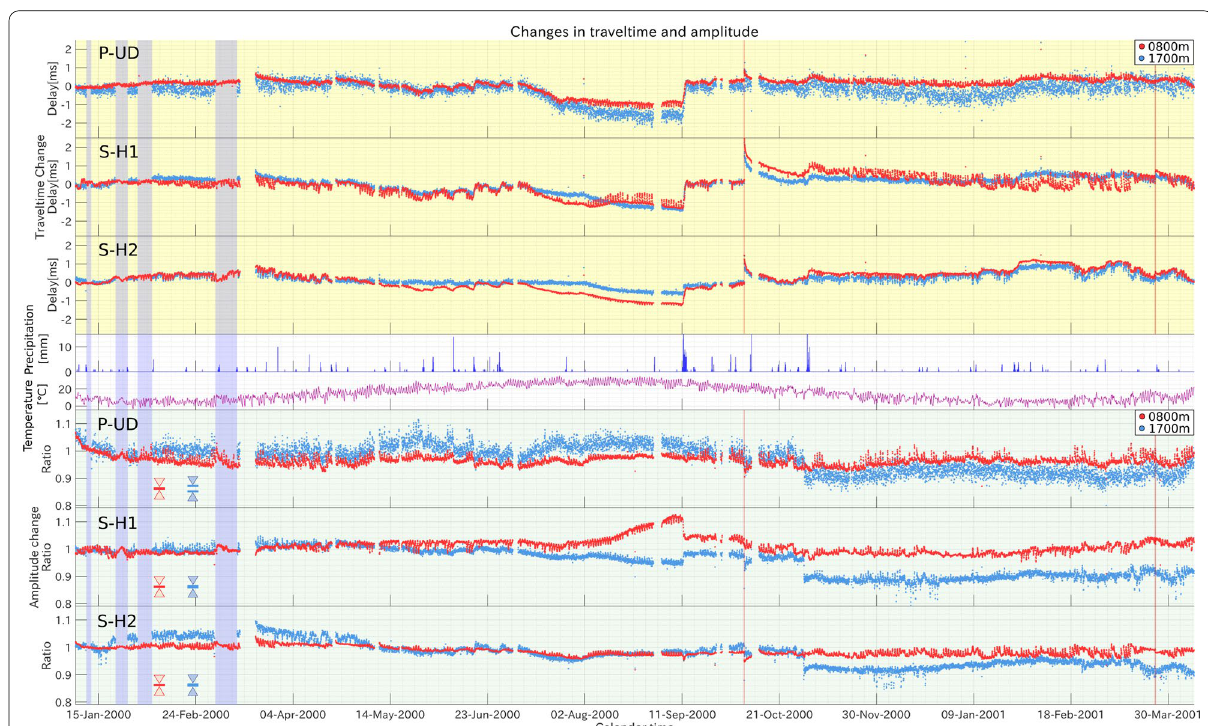
Fig. 5 Change in travel time and amplitude throughout the observation period. The changes in travel time (top three panels with yellow background) are calculated according to Ikuta et al. (2002) and changes in amplitude (bottom three panels with green background) are obtained by our method. The two panels in the middle illustrate atmospheric temperature and rainfall observed at Gunka station, which is the nearest meteorological station of the Japan Meteorological Agency. Blue shading shows the periods of the water injection experiments. The red vertical lines show the time of the earthquakes mentioned in the text. The gap between horizontal lines with a pair of triangles in the left shows the mean error of the amplitude change calculated by Eq. (6). The colors of the lines and triangles correspond to sensors in the legend on the